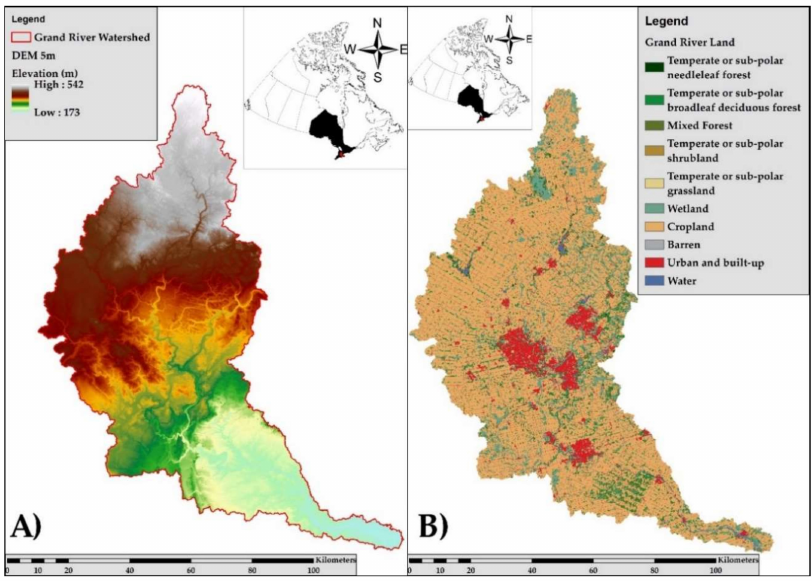
Figure 1. Grand River watershed ( A ) elevation map and ( B ) land cover